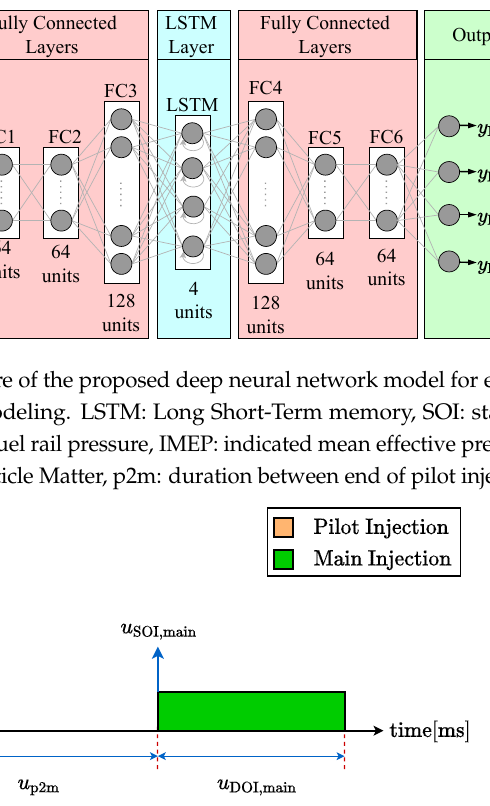
Figure 3. Diesel engine multiple injections. SOI: start of injection, DOI: duration of injection, p2m: duration between end of pilot injection and start of main